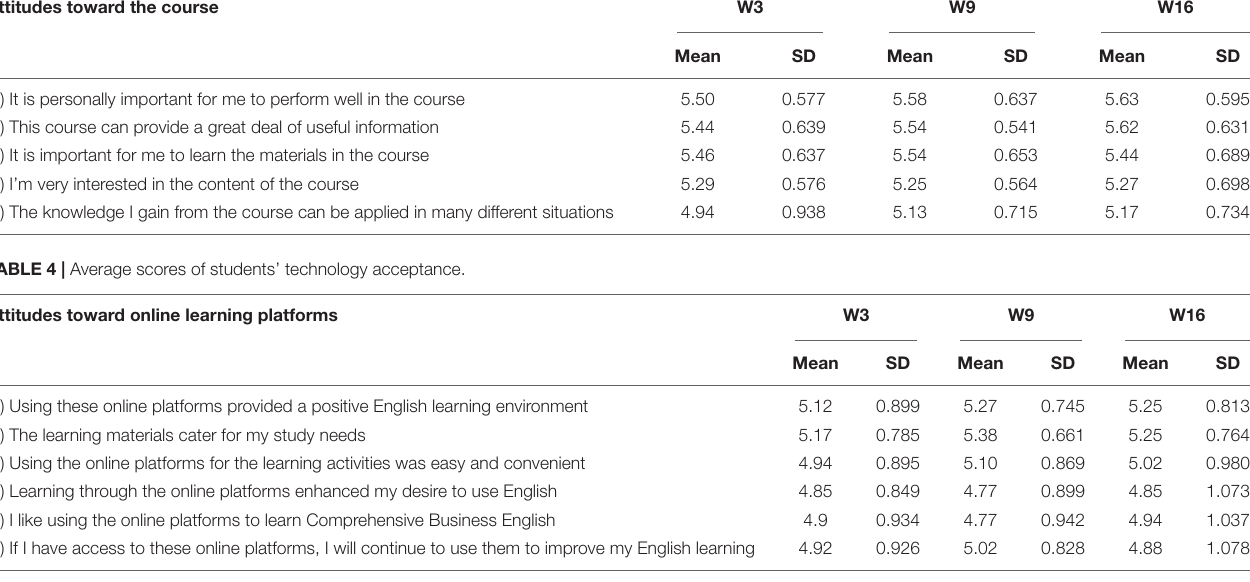
TABLE 3 | Mean scores of students’ attitudes toward the course. Attitudes toward the course